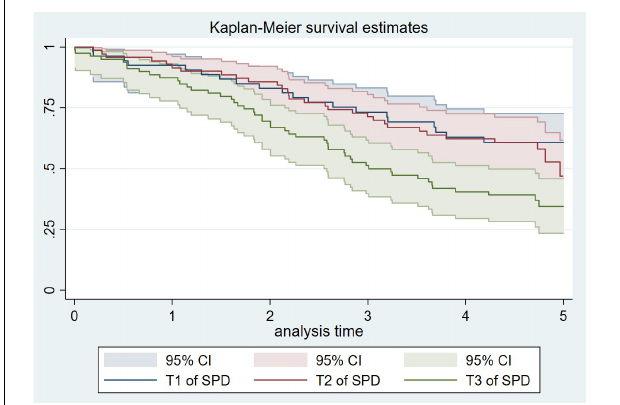
FIGURE 1 | Kaplan–Meier curves for incident stroke according to the tertiles of serum spermidine of nested case-control